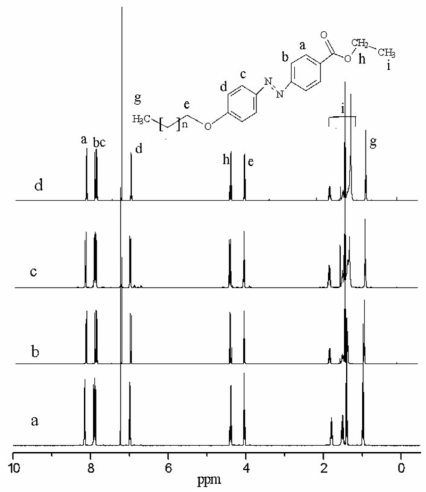
Figure 1. 1 H NMR spectra of compound